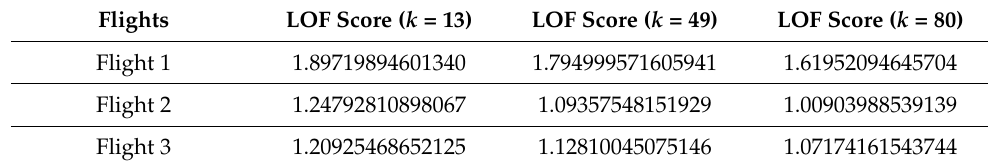
Table 1. Outlying nature of flights for different k